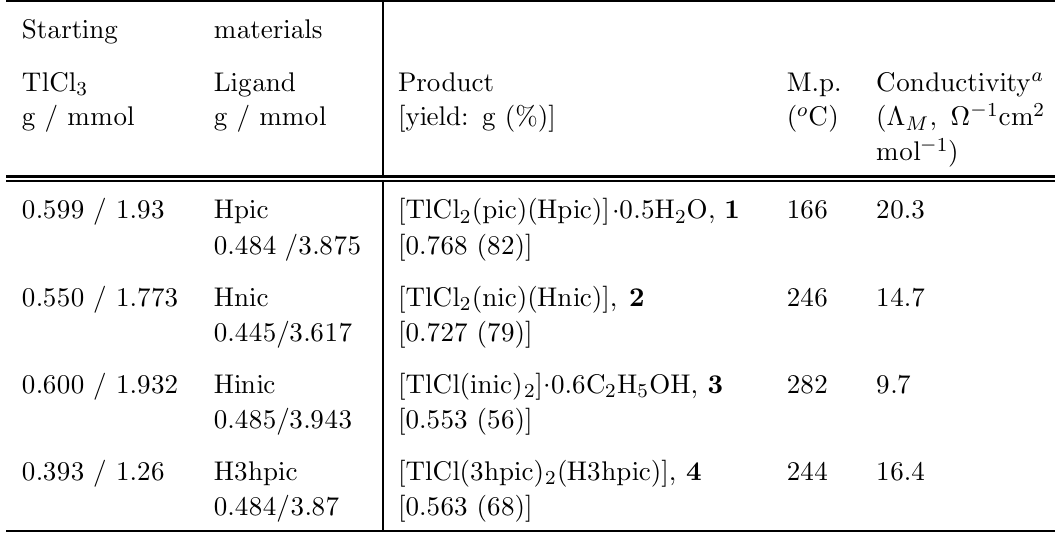
Table 1 Preparation data and some physical properties for TlCl 3